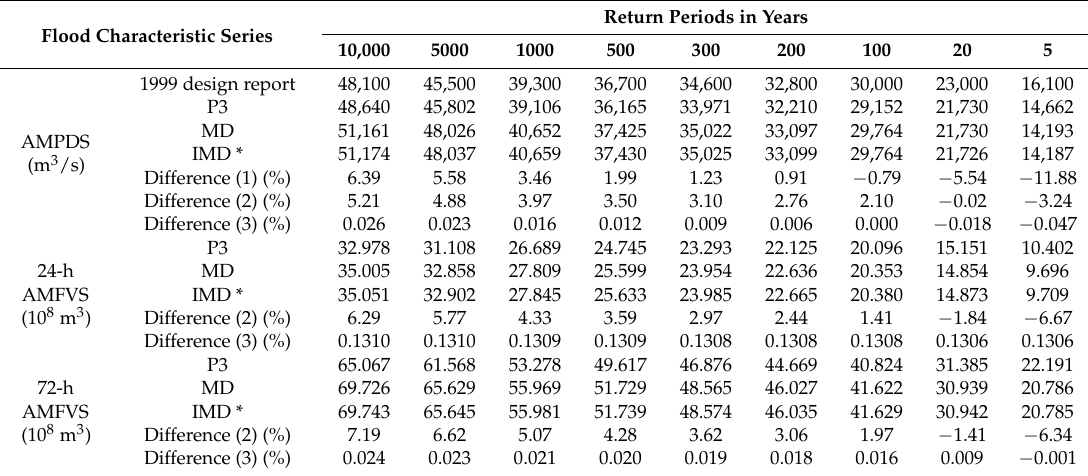
Return Periods in